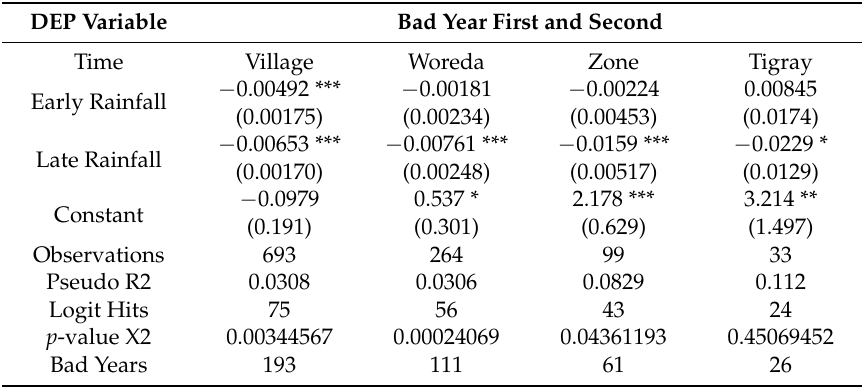
Table 4. Spatially-aggregated results for first and second (21 villages).